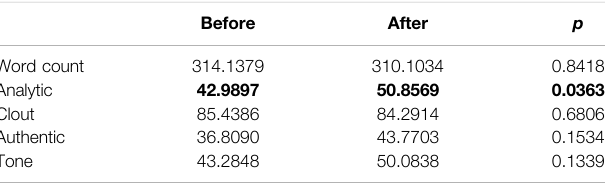
TABLE 1 | Change in Linguistic Inquiry and Word Count (LIWC) scores of trainees after training. Before After